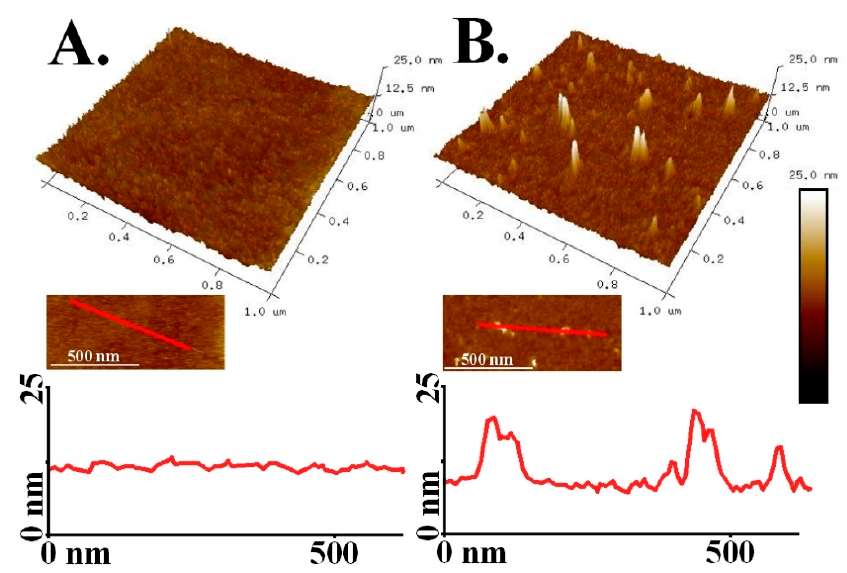
Figure 2. AFM images of poly(APTAC) brushes ( A ) and poly(APTAC)+SPIONs brushes ( B ) with the corresponding cross-sections.